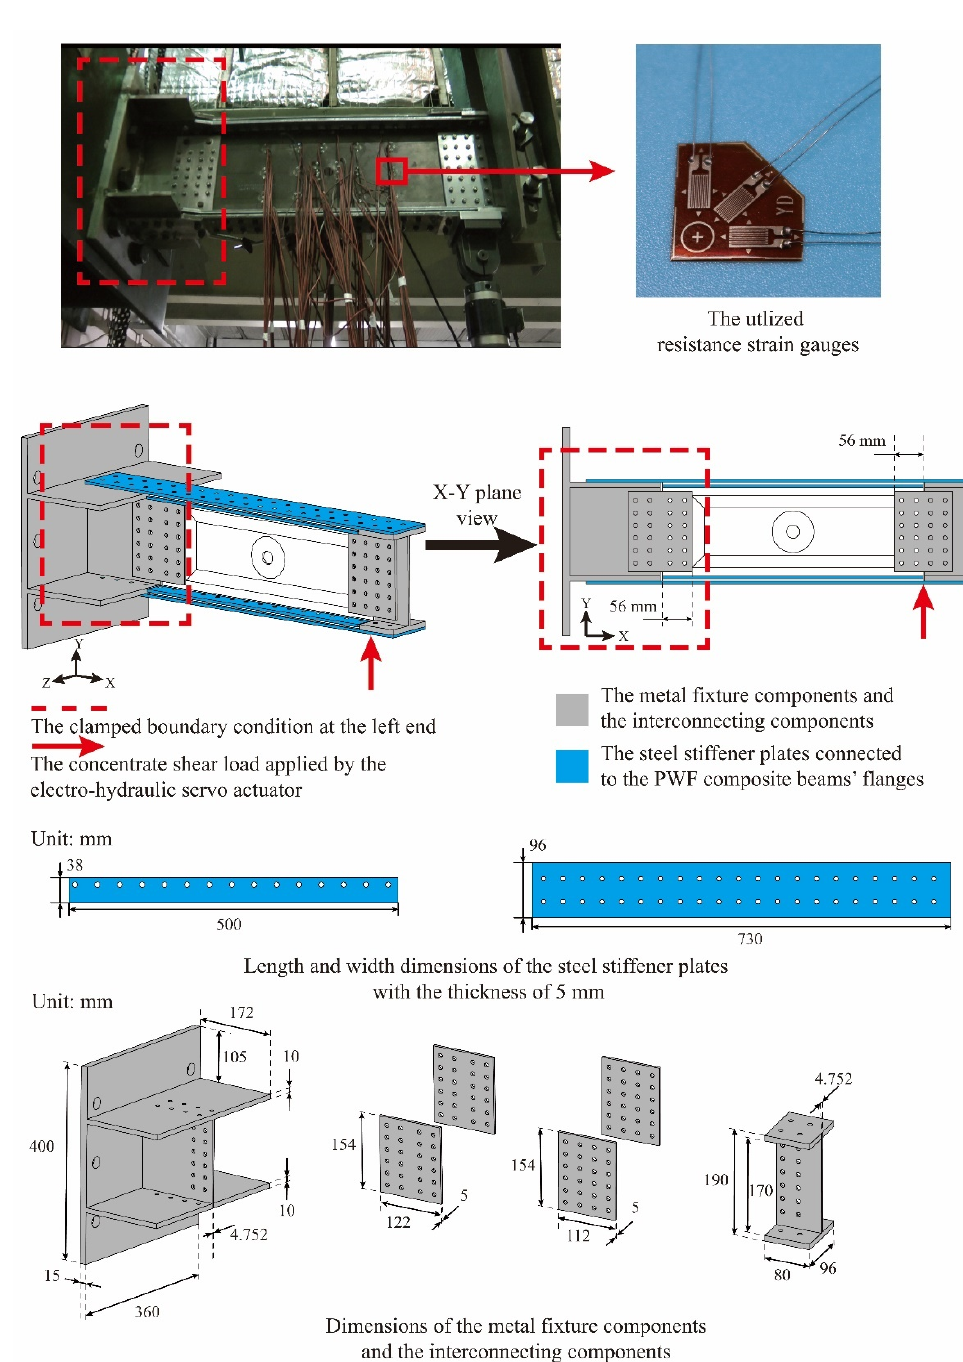
Figure 2. Shear experiment on the PWF composite I-section beams.